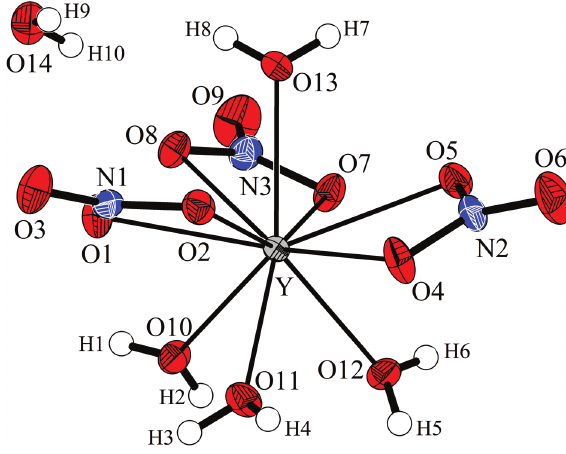
Table 1: Data collection and